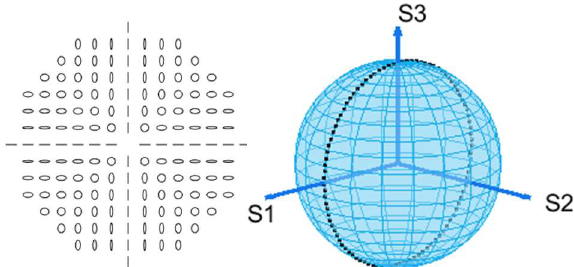
Figure 1: Visualisation of the ideal polarisation vector distribution in the cross-section of the Poincaré beam. The polarisation vectors/ellipses in the cross-section symbolise linear, right-handed and left-handed polarisation. Polarisation handedness is the same for diagonal quadrants. The polarisation vectors of the beam are depicted on the Poincaré